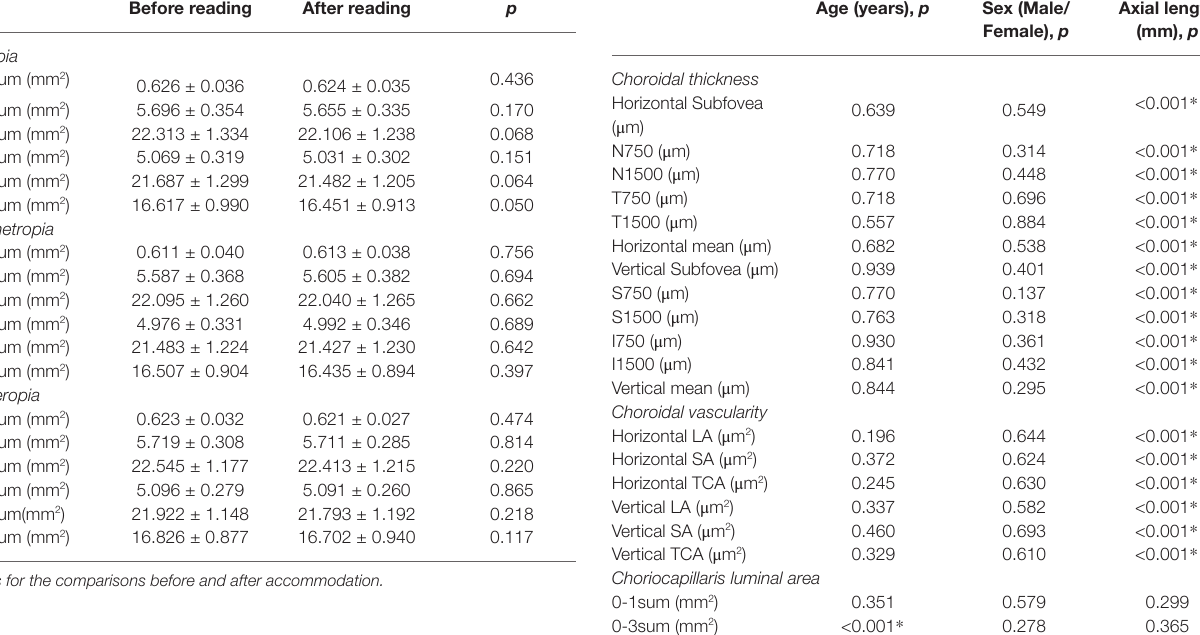
TABLE 8 | The univariate linear regression of associations of baseline choroidal parameters with age, sex, axial length. Age (years), p Sex (Male/ Axial length Female), p (mm), p